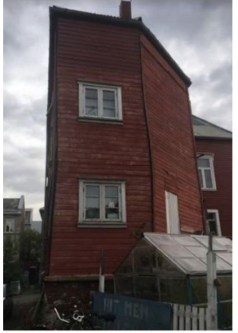
Figure 6. Leaning house